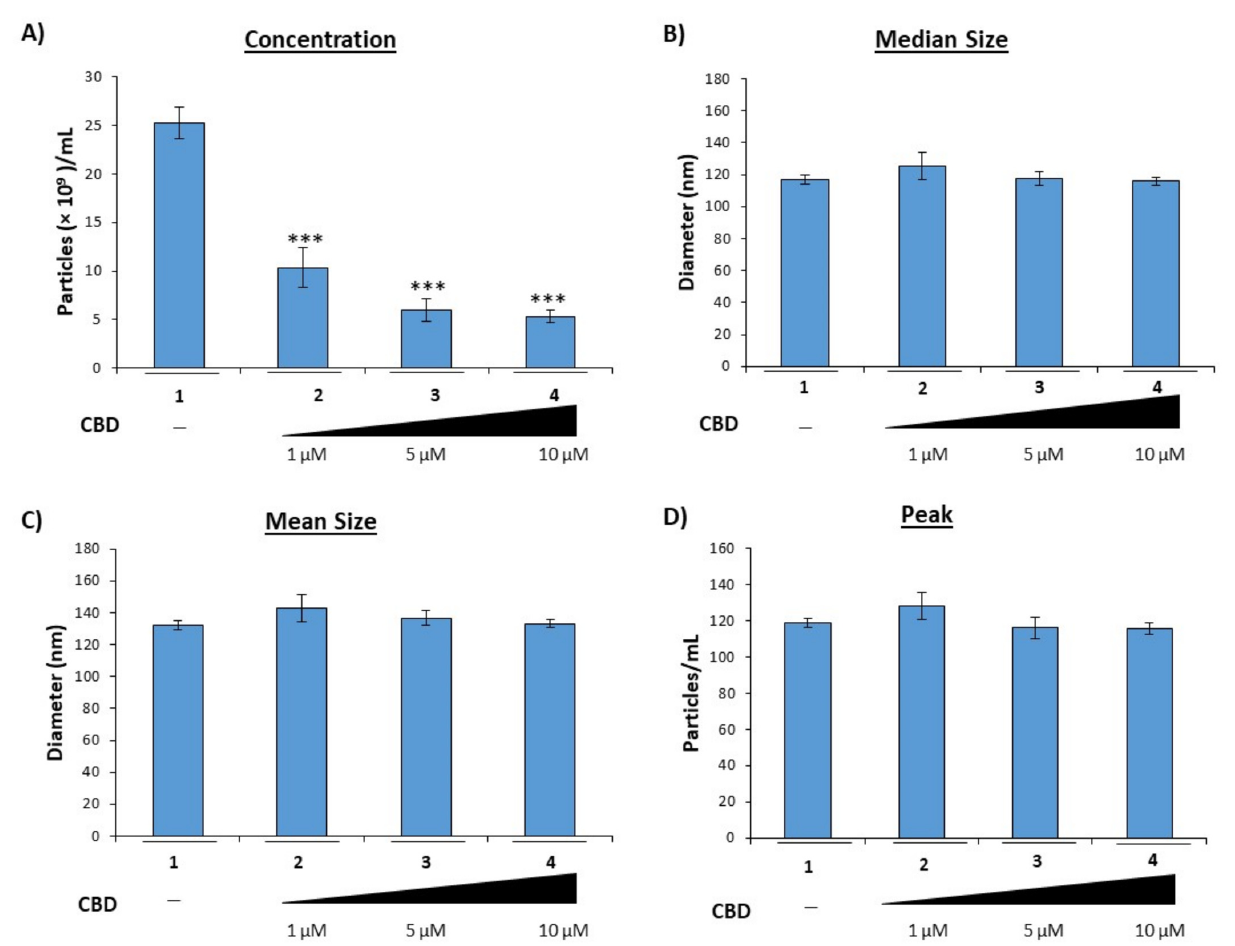
Figure 1. CBD lowers EVs released from HIV-1 infected monocytes. HIV-1 infected U1 monocytic cells (1 × 10 6 ) were treated with a titration of CBD (1, 5, and 10 µ M) every day for 5 days. Cells were pelleted, and supernatant was used for Zetaview NTA analysis to determine ( A ) EV concentration, ( B ) median size, ( C ) mean size, and ( D ) peak size. Each bar represents an average of three independent replicates. Student’s t -test was used for statistical analysis, where *** = p <